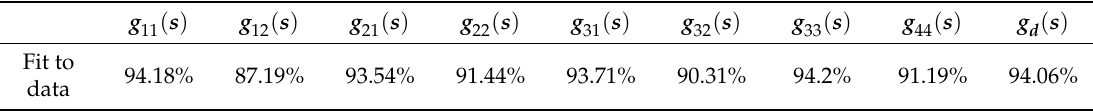
Table 3. The model fitness to the step-response